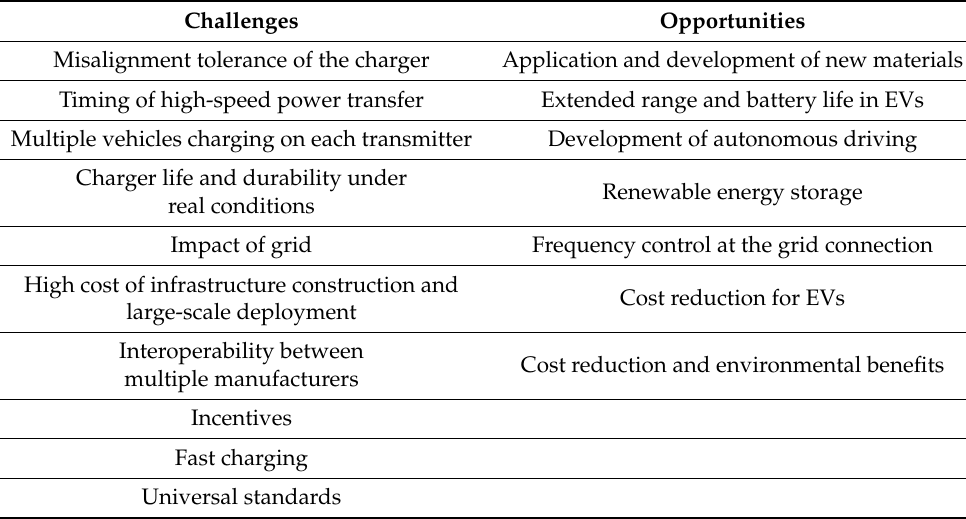
Table 1. Summary of challenges and opportunities of application of wireless charging in EVs [46].